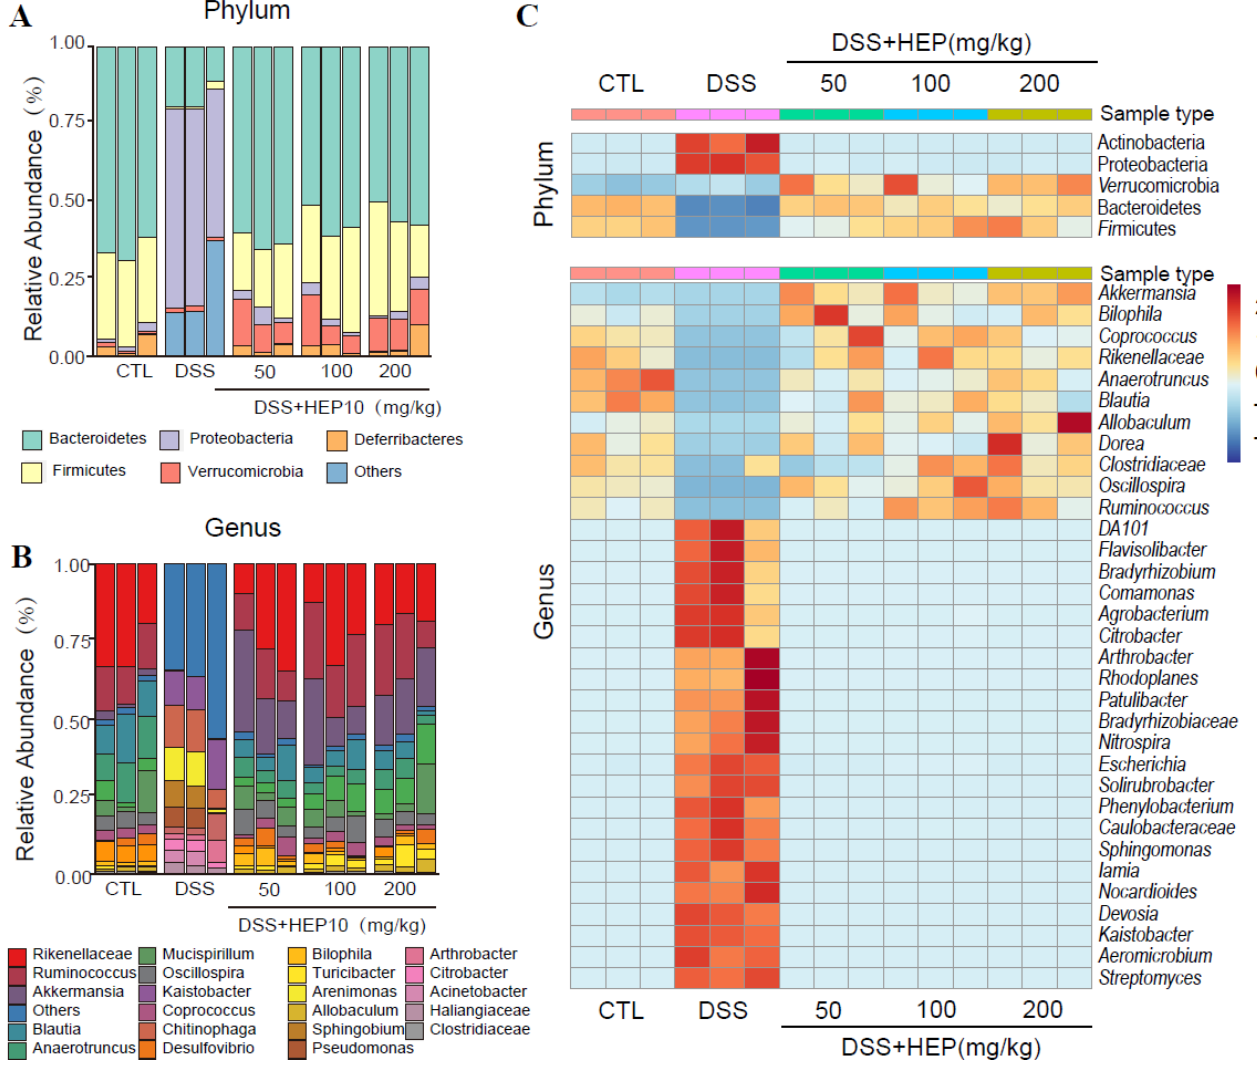
Figure 8. Comparisons of gut microbial compositions. ( A , B ) Compositions at the phylum and genus levels. ( C ) The heatmap shows the abundance of top 5 phyla and top 33 genera altered by HEP10 in DSS-induced mice model.